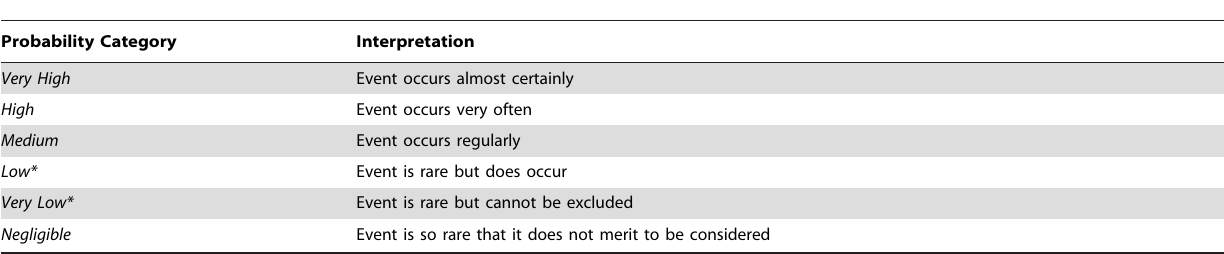
Table 2. Definitions of risk